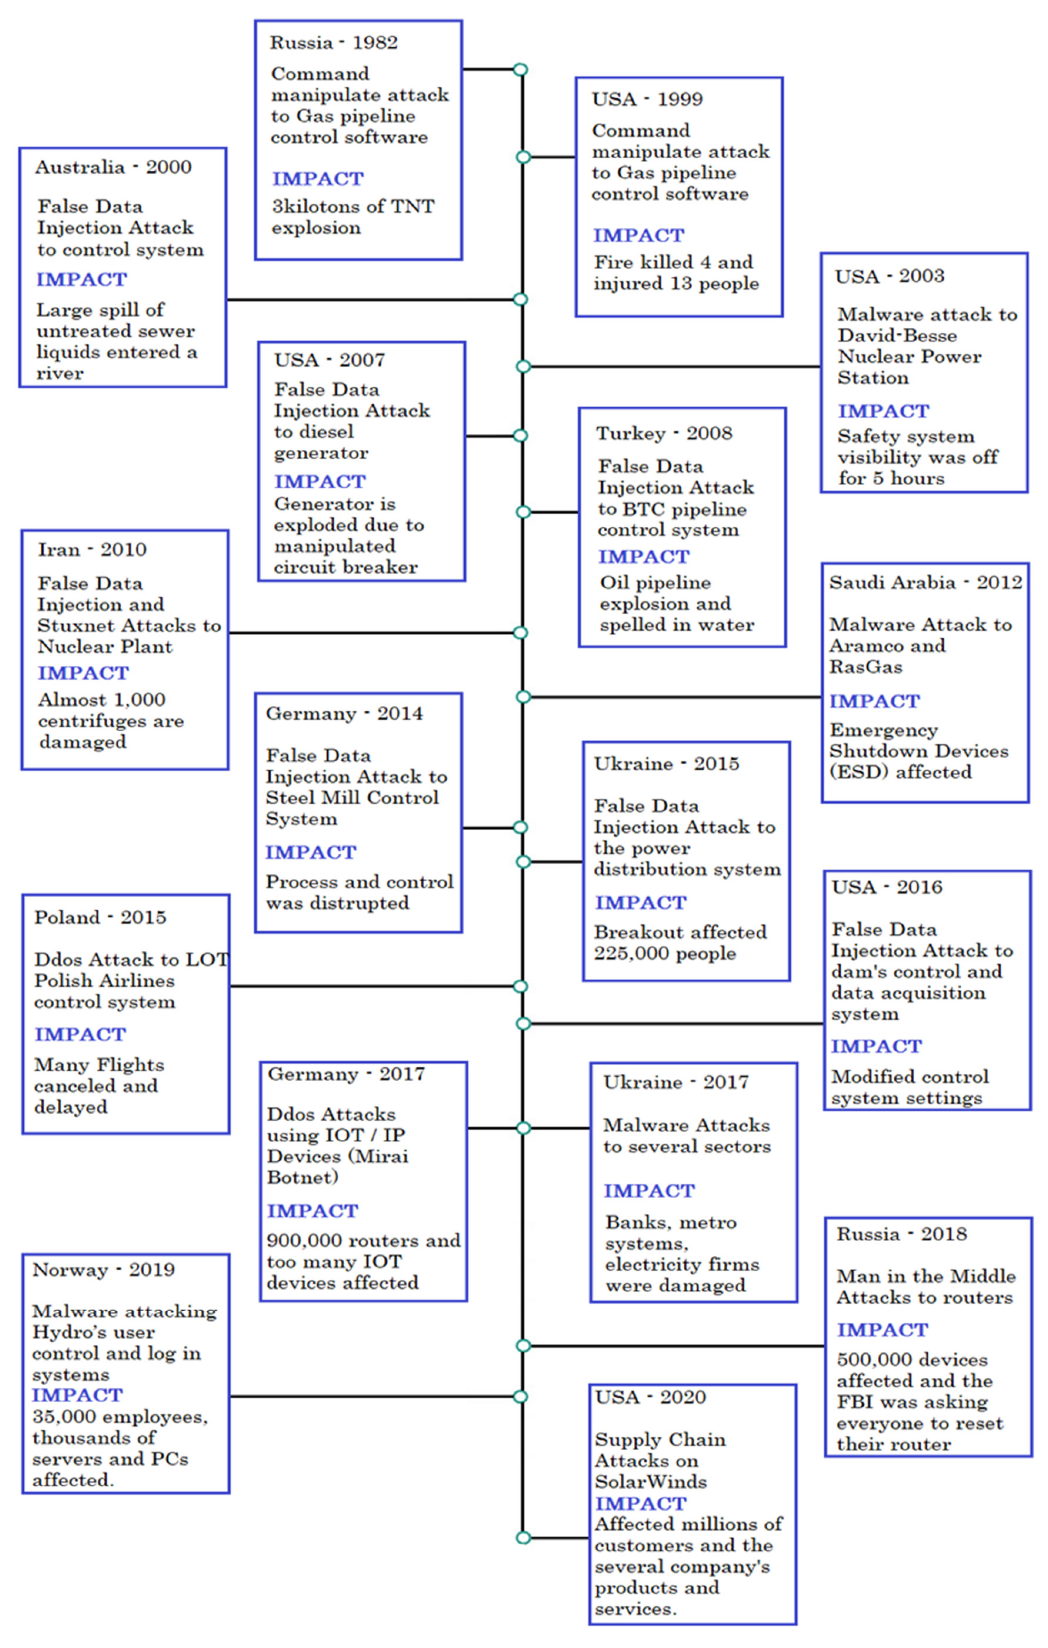
Figure 6. Timeline of essential cyber-attacks over the past two decades.